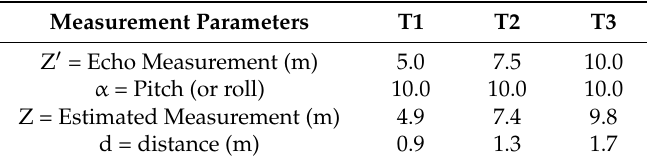
Figure 8. Vertical error in depth measuring due to the wave effect.